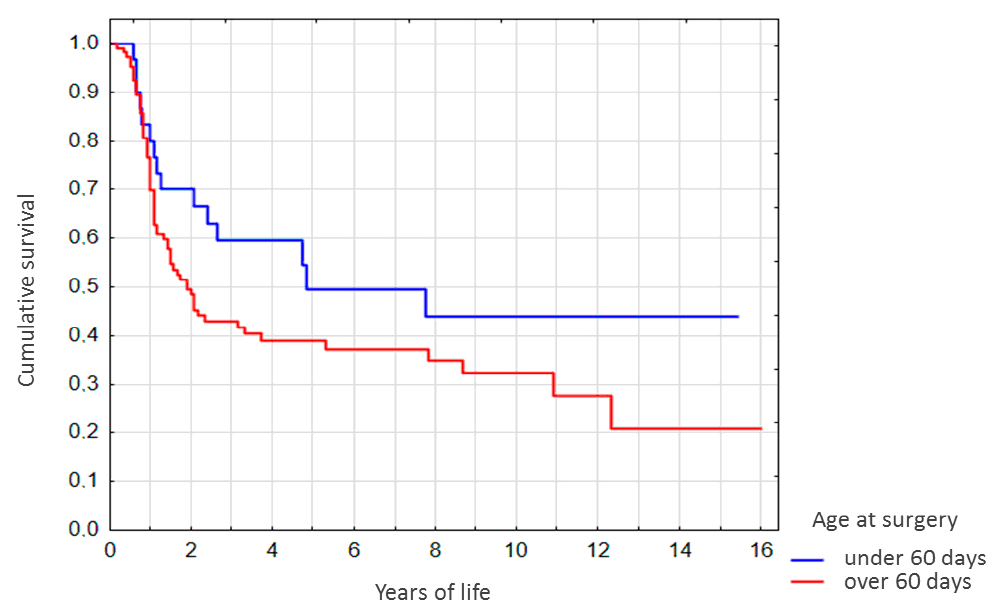
Figure 3. Survival curves for the non-LT subgroup stratified by age at Kasai surgery.